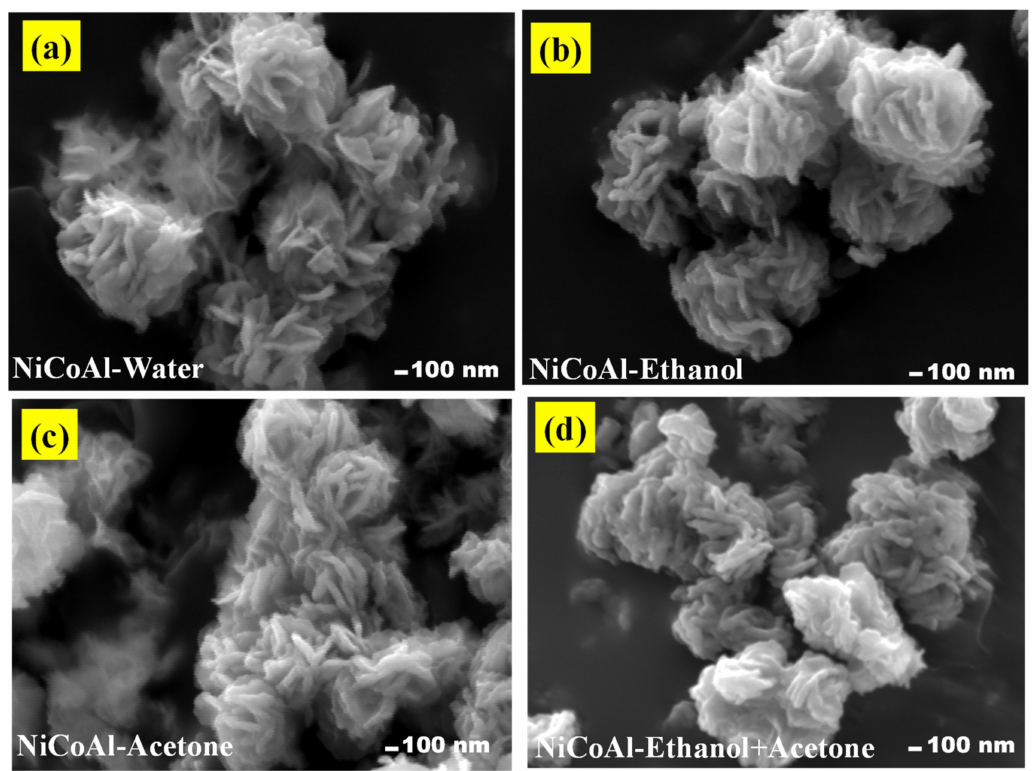
Figure 3. SEM images of ( a ) NiCoAl-water, ( b ) NiCoAl-Ethanol, ( c ) NiCoAl-Acetone, and ( d ) NiCoAl- Ethanol + Acetone.